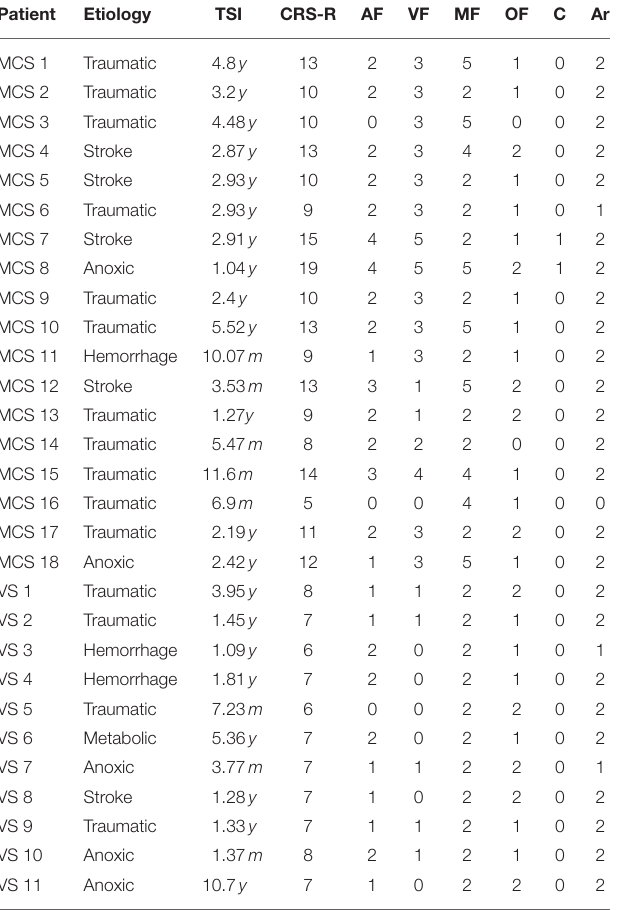
TABLE 1 | Demographic data for minimally conscious (MCS) and vegetative (VS) patients. Patient